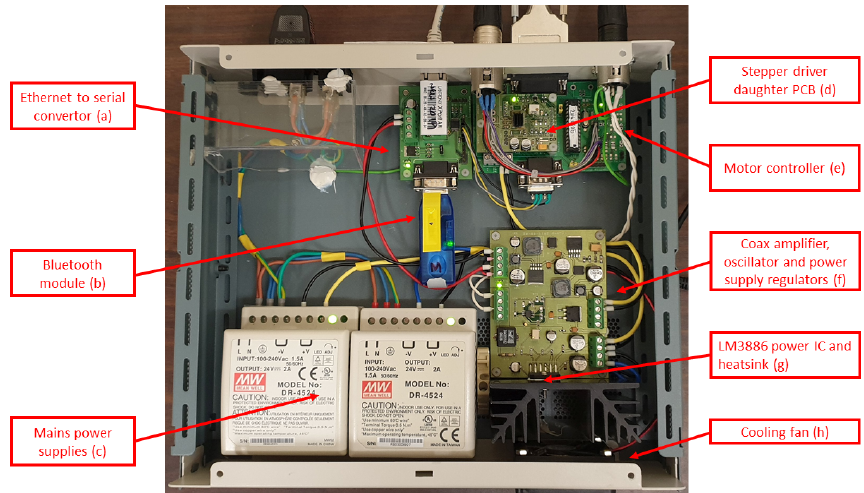
Figure 8. Main electronics